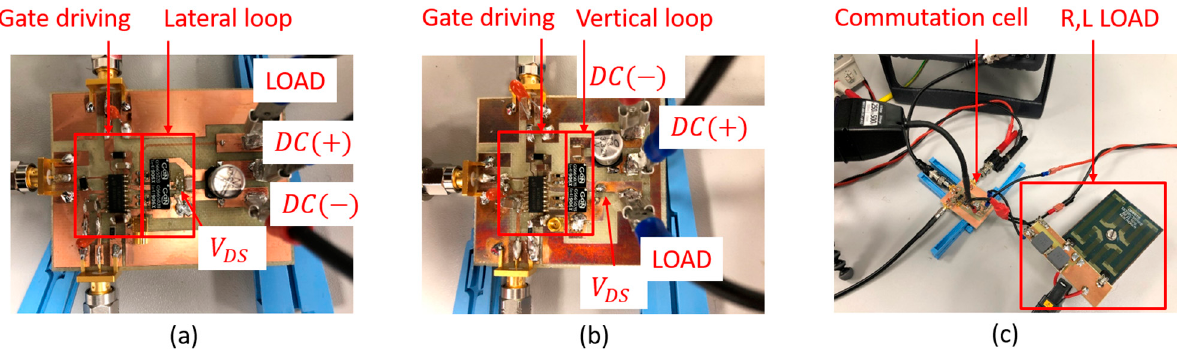
Figure 24. Converters tests: ( a ) commutation cell with lateral loop; ( b ) commutation cell with vertical loop; ( c ) test setup with commutation cell, DC load and optically isolated voltage probes.